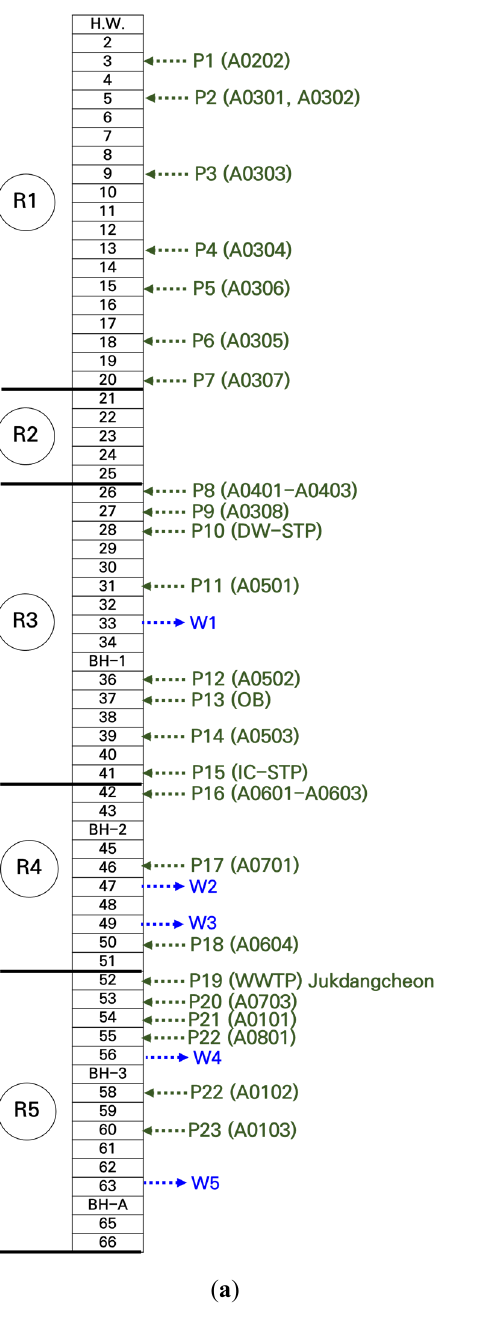
Figure 4. Schematic diagrams of QUAL-MEV model: ( a ) schematic diagram applied to 1st TMDL Plan; ( b ) schematic diagram that shows tributaries added in this study. Table 5. QUAL-MEV model segmentation scheme of Bokha